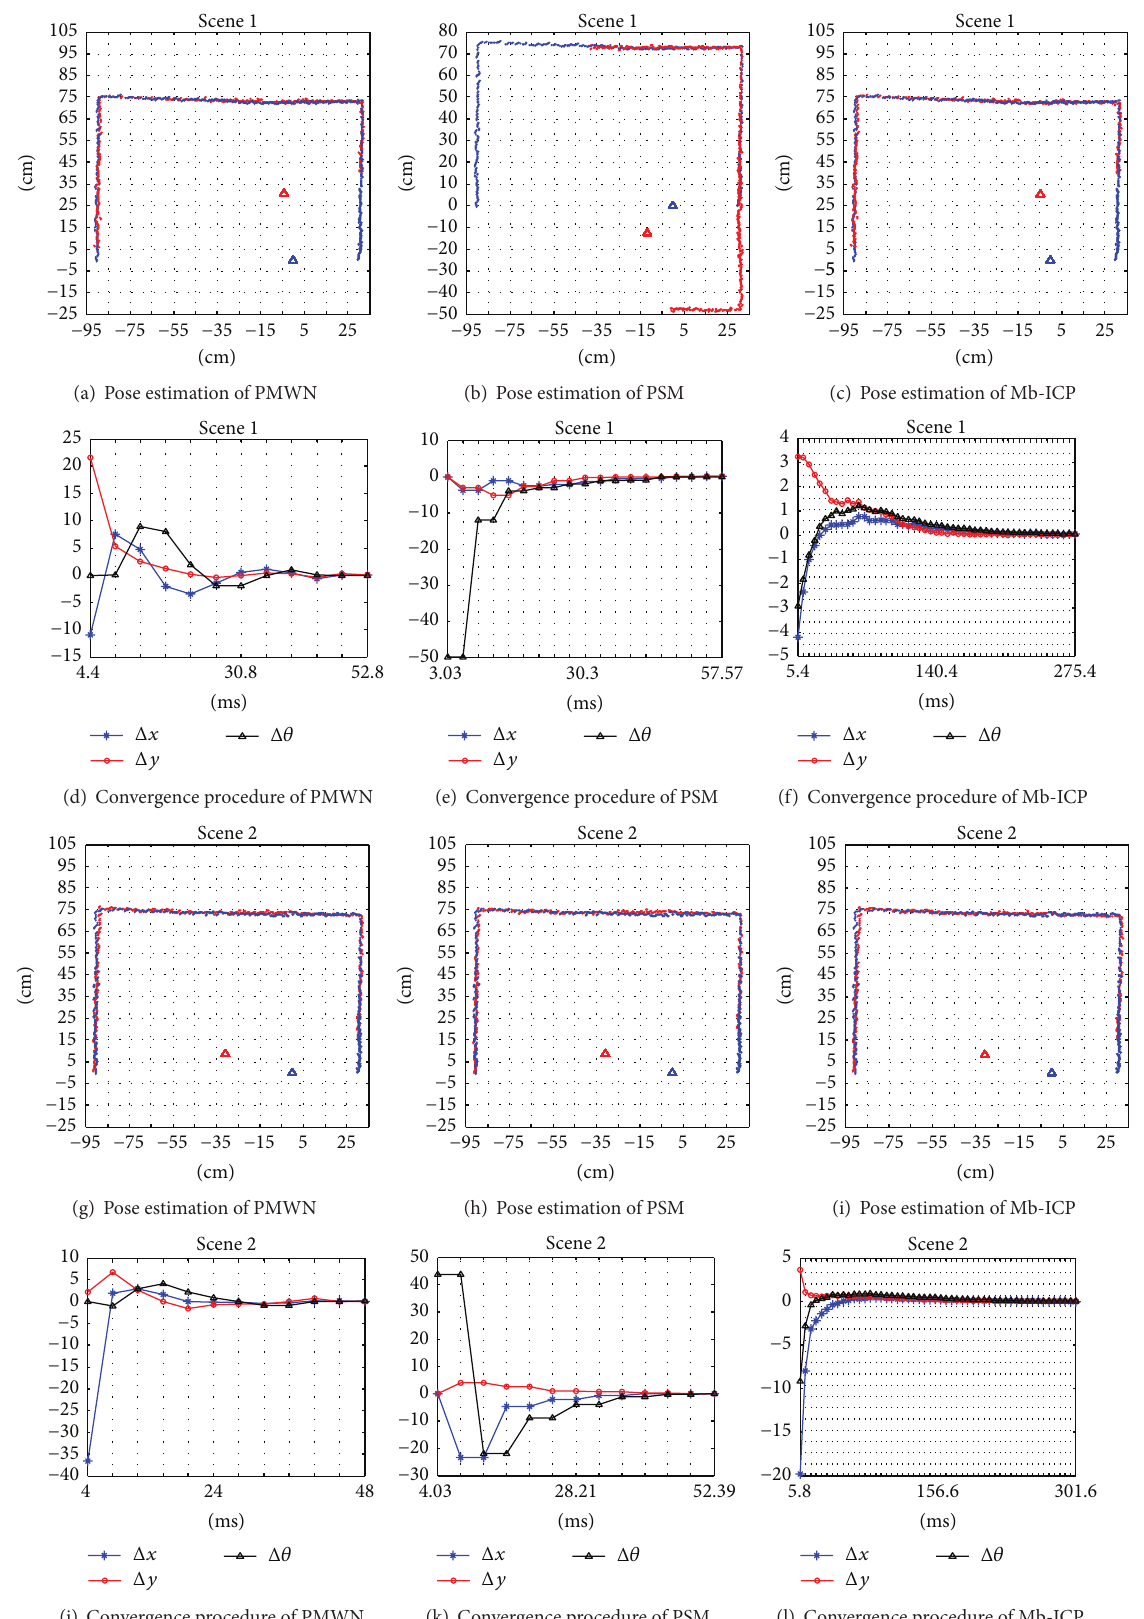
Figure 9: Scenes in Environment